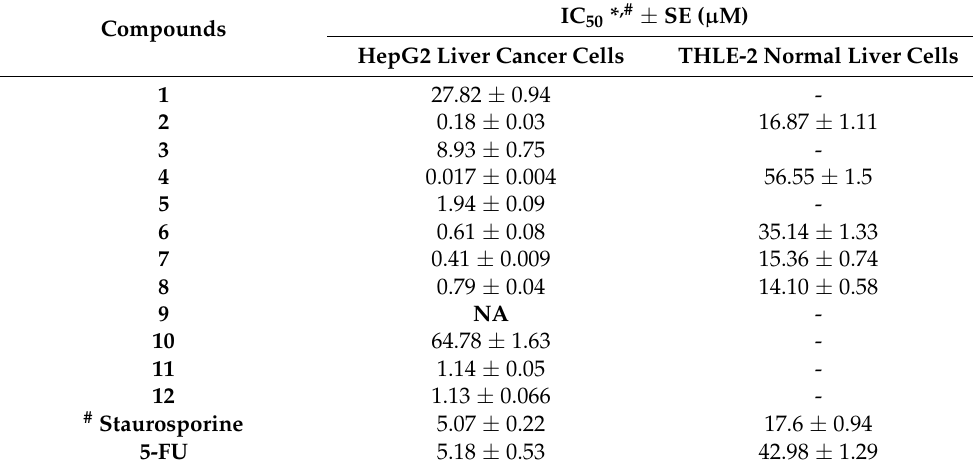
Table 1. Summarized IC 50 values for the activity of the twelve 2-thioxoimadazolidin-4-one com- pounds 1 – 12 against (HepG2) and (THLE-2) using the MTT assay. IC 50 * ,# ± SE ( µ M) Compounds HepG2 Liver Cancer